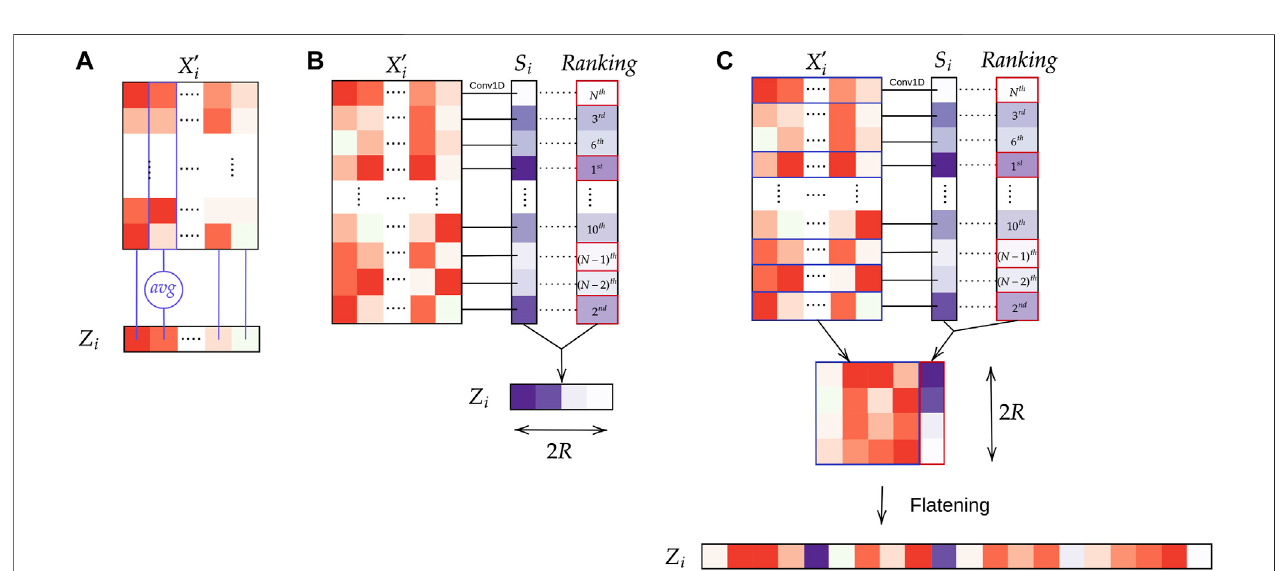
FIGURE 6 | Aggregation layers: (A) Average pooling; (B) WELDON pooling; (C) WELDON-C pooling which is WELDON concatenated with previous tile encoding.